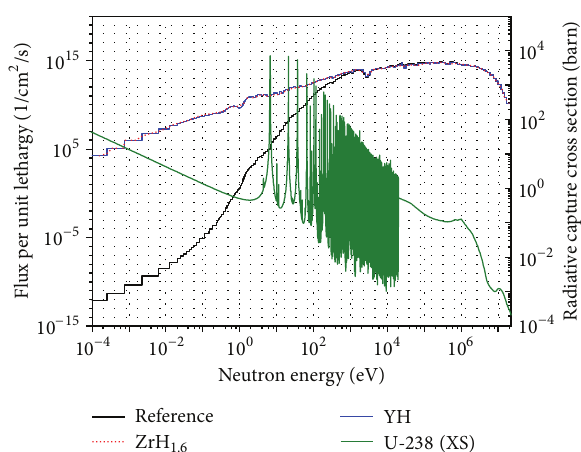
Figure 3: Neutron spectrum for the reference fuel assembly and for the fuel assemblies with moderating material based on different hydrogen carrying materials calculated with the 190 group library of HELIOS